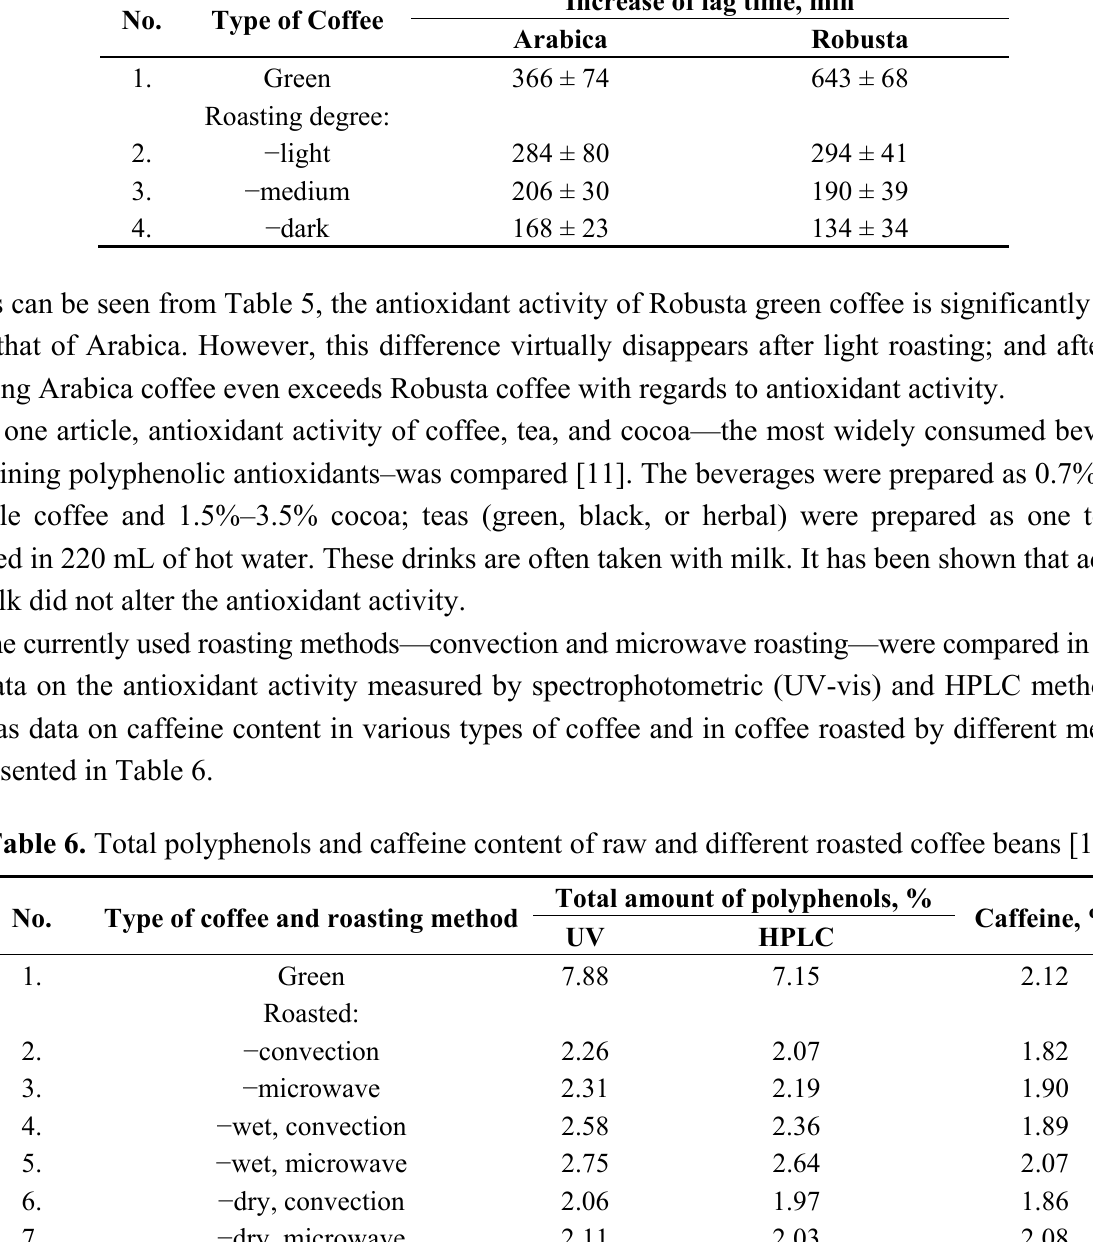
Table 5. Antioxidant activity of green and roasted Arabica and Robusta coffee beans [11]. No. Type of Coffee